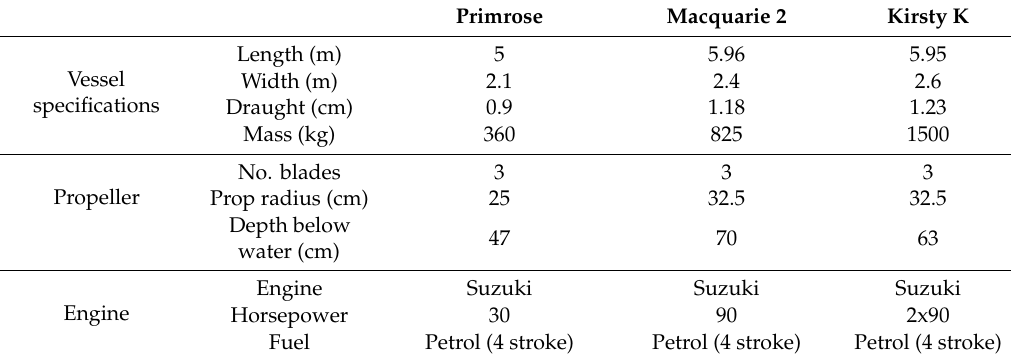
Table 1. Specifications of vessels recorded in Lizard Island